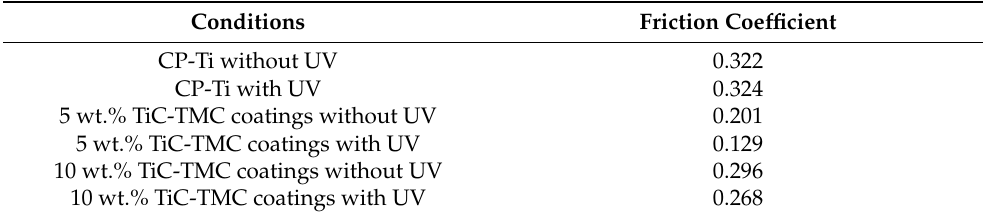
Table 4. The average friction coefficient of the CP-Ti and TiC-TMC